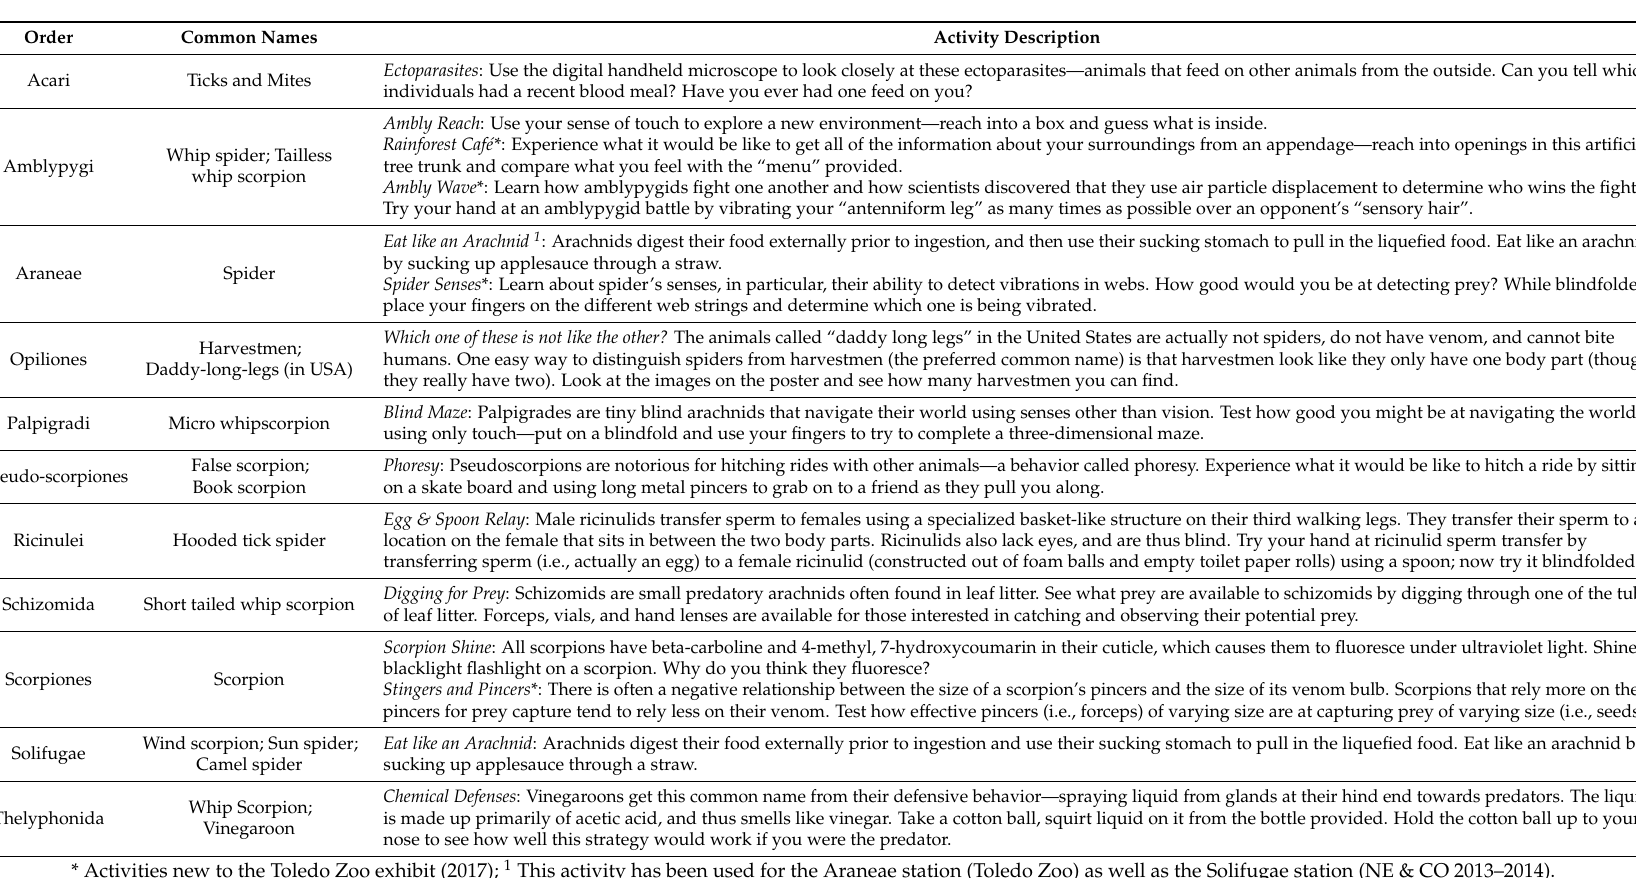
Table 4. Path of Predators Activities. All eleven stations were implemented at four of the five focal events (Morrill Hall, NE 2013 and 2014; Butterfly Pavilion; and Denver Museum of Nature and Science). At the Toledo Zoo the Mini Path of Predators was implemented (Amblypygi, Araneae, Scorpiones, Thelyphonida). Disciplinary Core Ideas (NGSS) covered in the Path or Predators activities include: LS1.A: Structure and Function; LS1.B: Growth and Development, LS1.D: Information Processing; LS2.A: Interdependent Relationships in Ecosystems; LS4.B: Natural Selection; and LS4.C: Adaptation; LS4.D: Biodiversity and Humans. Cross-Cutting Concepts include Scale, Proportion, and Quantity and Science Addresses Questions about the Natural and Material